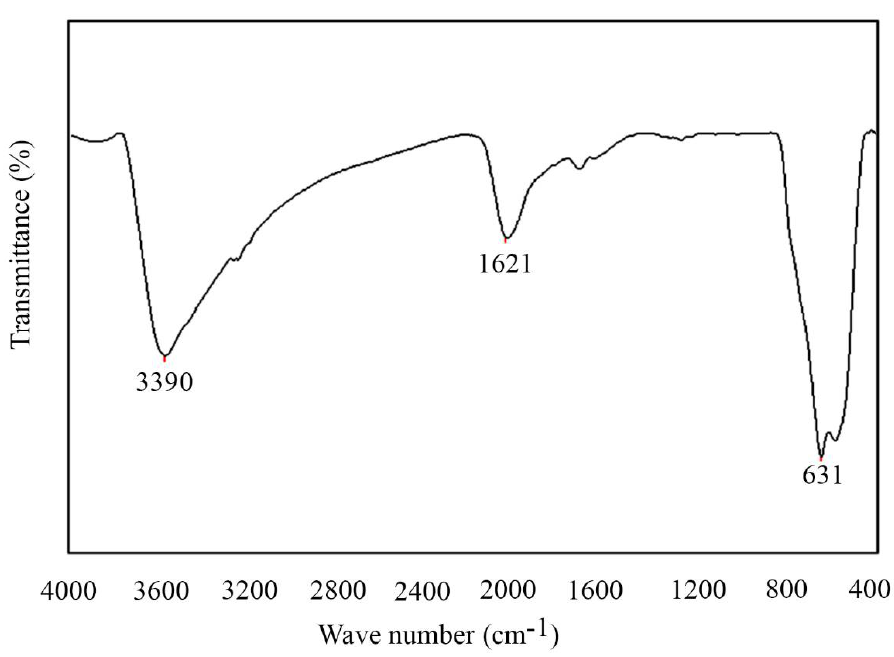
Figure 3. FTIR spectra of Lys@Fe 3 O 4 nanoparticles.